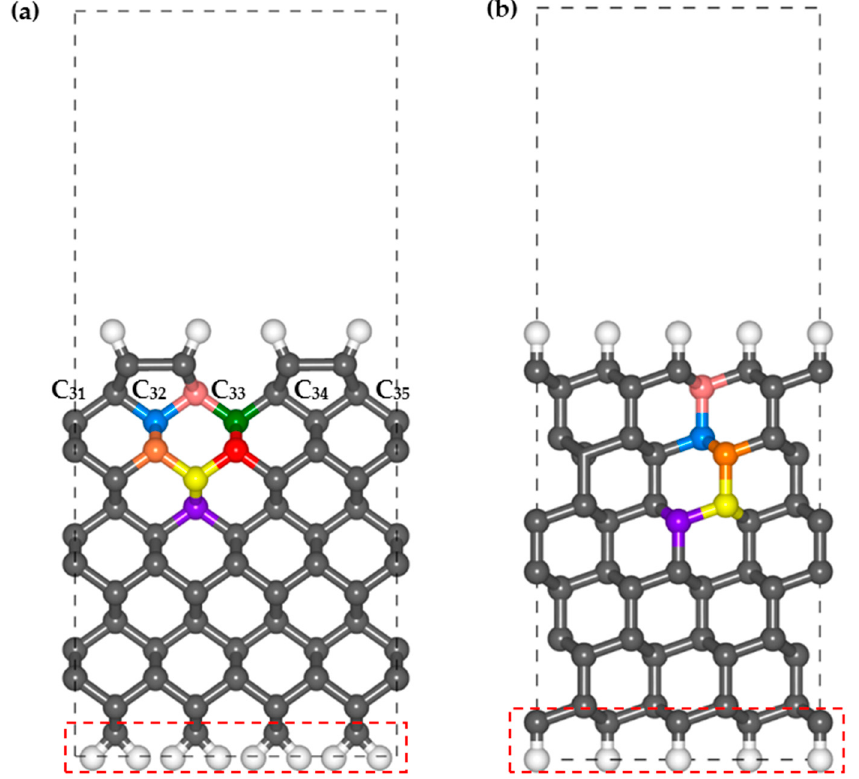
Figure 1. Schematic of the substitutional locations of the P and V on the (001) and (111) surfaces. ( a ) The doping location of P(V) on the (001) surface. ( b ) The doping location of P(V) on the (111) surface (white: H; gray: C; pink, blue, green, orange, red, yellow, and purple: P(V) in the site 2A, 3A, 3B, 4A, 4B, 5A, and 6A, respectively) the bottom two layers, framed by the red dotted line, are the atoms that are fixed during the calculation.